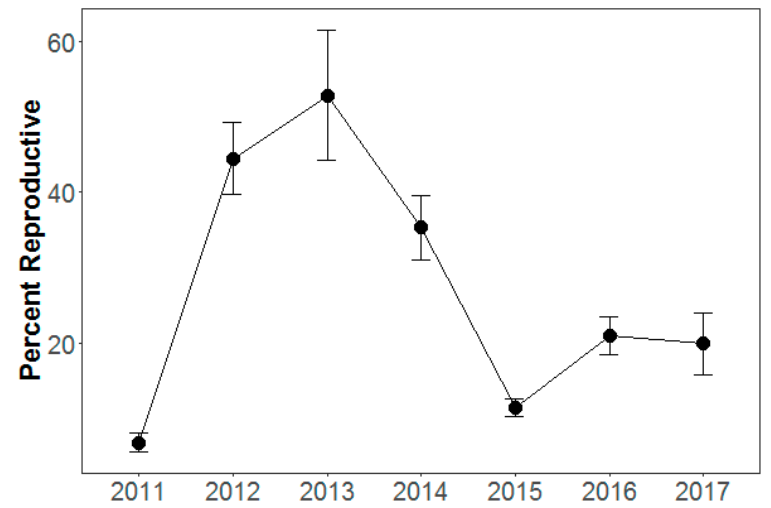
Figure 10. Mean (±SE) percent of shoots that were reproductive integrated across the entire transect lengths for every year after the 2010 die-off event.